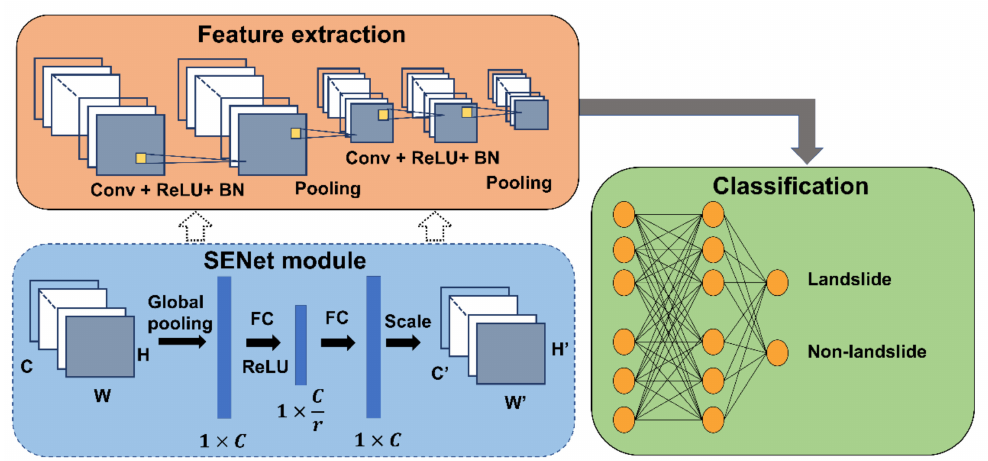
Figure 5. The architecture of the CNN-based landslide susceptibility